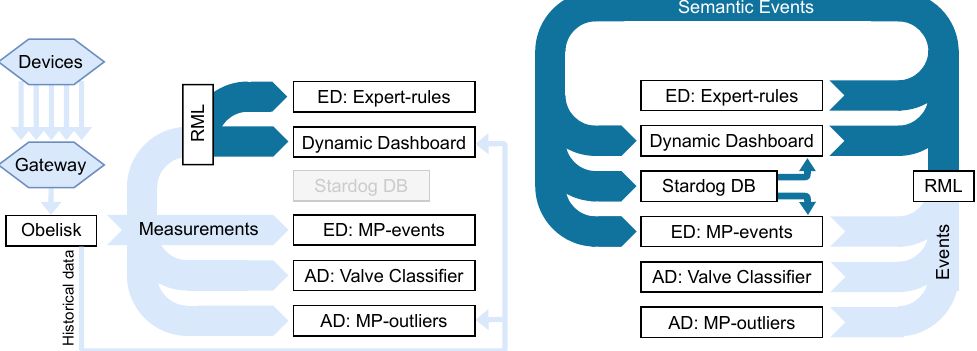
Figure 1. Flow of measurement ( left ) and event data ( right ) throughout the different microservices or microservice-based components (rectangles). Events are generated by the services after processing measurements. The thick bands represent data flow through Kafka topics, while arrows represent flow through HTTP API calls. Light colors indicate non-semantic (JSON) data; dark colors indicate semantic (JSON-LD) data. Measurements are ingested and persisted by Obelisk. The event detection (ED) and anomaly detection (AD) services process the measurements and produce messages for certain observed patterns. The RML component maps non-semantic data to a semantic format and Stardog is a semantic database that is used to store the semantic events. The dashboard is the only user-facing component and visualizes both measurements and detected